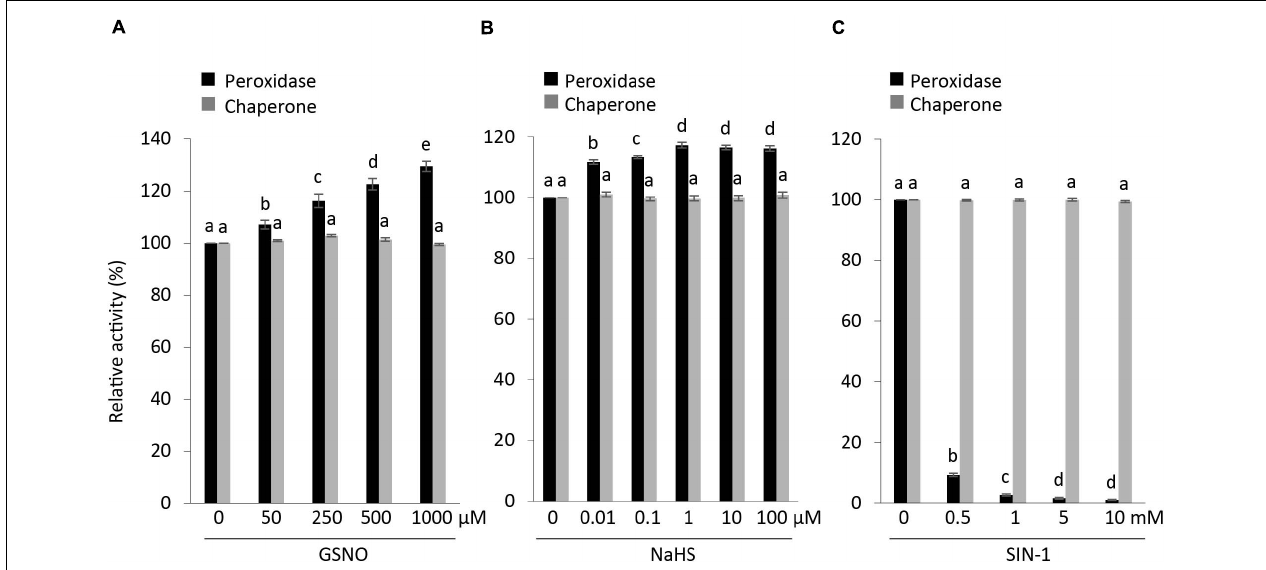
FIGURE 6 | Effects of posttranslational modifications on structural and functional status of AtAPX1. Comparison of peroxidase and chaperone activity of AtAPX1 protein treated with (A) GSNO (50–1,000 µ M) for 30 min at 25 ◦ C in dark (S-nitrosylation), (B) NaHS (0.01–100 µ M) for 30 min at 4 ◦ C in dark (S-sulfhydration), and (C) SIN-1 (0.5–10 mM) for 1 h at 37 ◦ C in dark (tyrosine nitration). The activities of treated protein were compared to non-treated protein whose activity was set to 100%. The black bars represent peroxidase activity and gray bars represent chaperone activity. Data are means ( ± ) standard deviation of three independent experiments. Different letters indicate significant differences at P < 0.05 between non-treated and treated protein samples by one-way ANOVA with Tukey’s test.